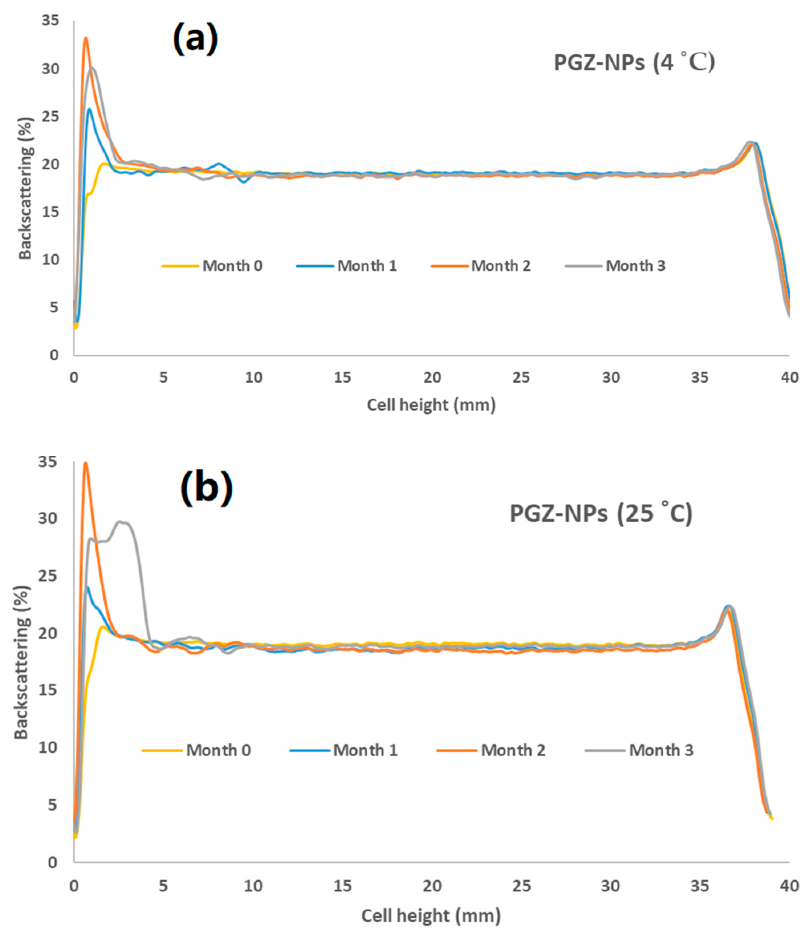
Figure 4. Stability of PGZ-NPs: ( a ) 4 °C and ( b ) 25 °C.